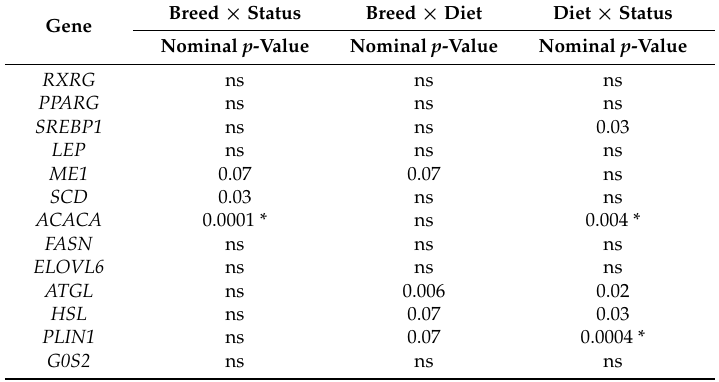
Figure 2. Fold-change (FC) ratios of candidate genes expression between fasting versus feeding status in ham subcutaneous adipose biopsies obtained from Duroc ( n = 19) and Iberian ( n = 29) pigs. The error lines indicate the standard errors. FC values > 1 indicate higher expression in fasting status. * p < 0.05, ** p < 0.01, *** p < 0.0001. Breed × status interaction effects are indicated with an arrow ( ↓ ) ( p < 0.07, p < 0.03 and p < 0.0001 for ME1 , SCD , and ACACA genes, respectively). Table 4. Breed × status, breed × diet and diet × status interaction effects on candidate genes expression. Breed × Status Breed × Diet Gene